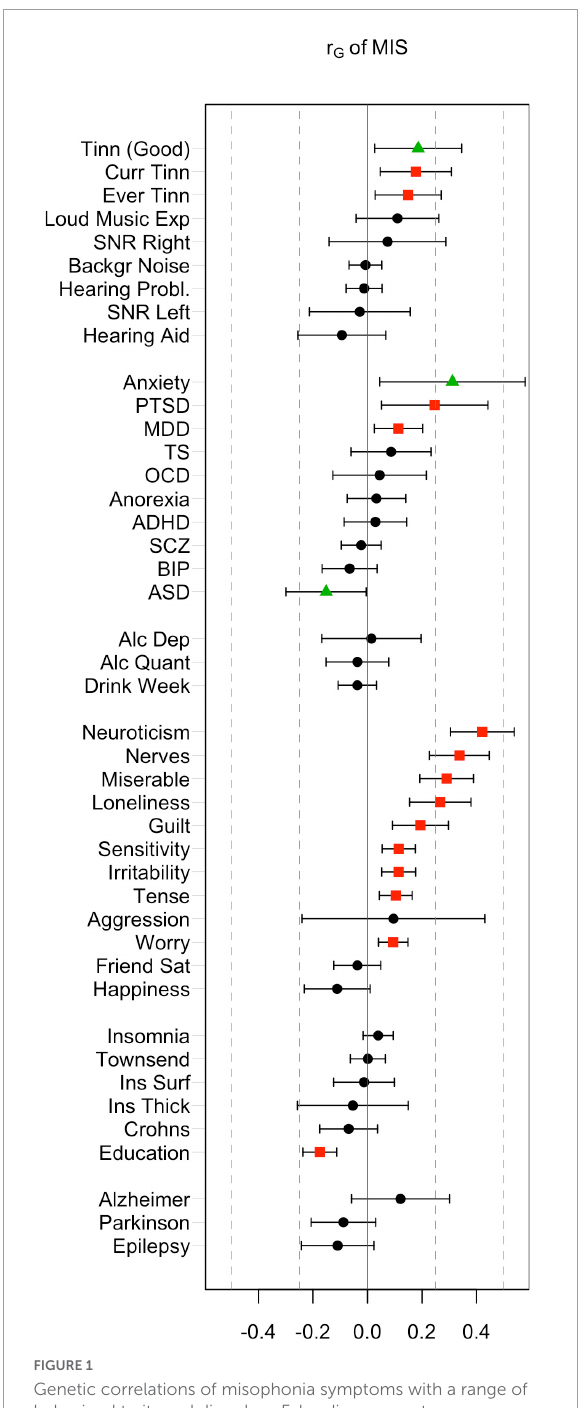
FIGURE1 Genetic correlations of misophonia symptoms with a range of behavioral traits and disorders. False discovery rate (FDR)-corrected significant effects (red) were observed in most categories (audiological, psychiatric, personality, and miscellaneous traits). Nominal significance (green triangles) was observed for Anxiety, autism spectrum disorder (ASD), and “Tinnitus in good hearing”. FDR adjusted significant correlations were observed for Current Tinnitus, Ever Tinnitus, post-traumatic stress disorder (PTSD), major depression disorder (MDD), a range of internalizing and externalizing traits, and educational attainment